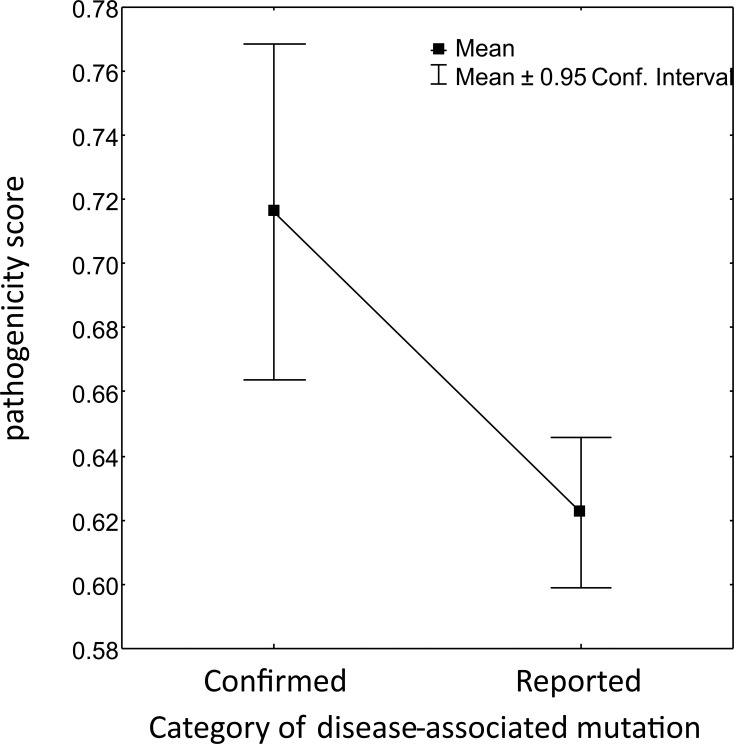
Predicted pathogenicity scores.Significant difference between means of predicted pathogenicity scores between confirmed disease-associated mutations and reported disease-associated mutations (t = 2.956; d.f. = 226; p = 0.003).